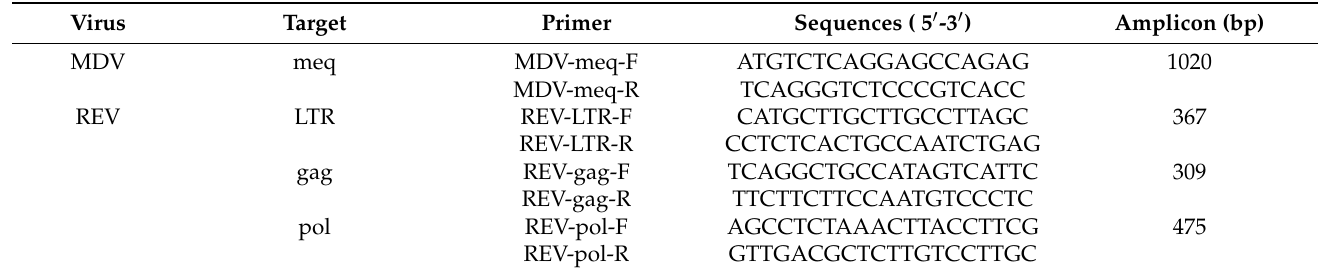
Table 2. Primers for amplifying the viral genes of MDV and REV used in this